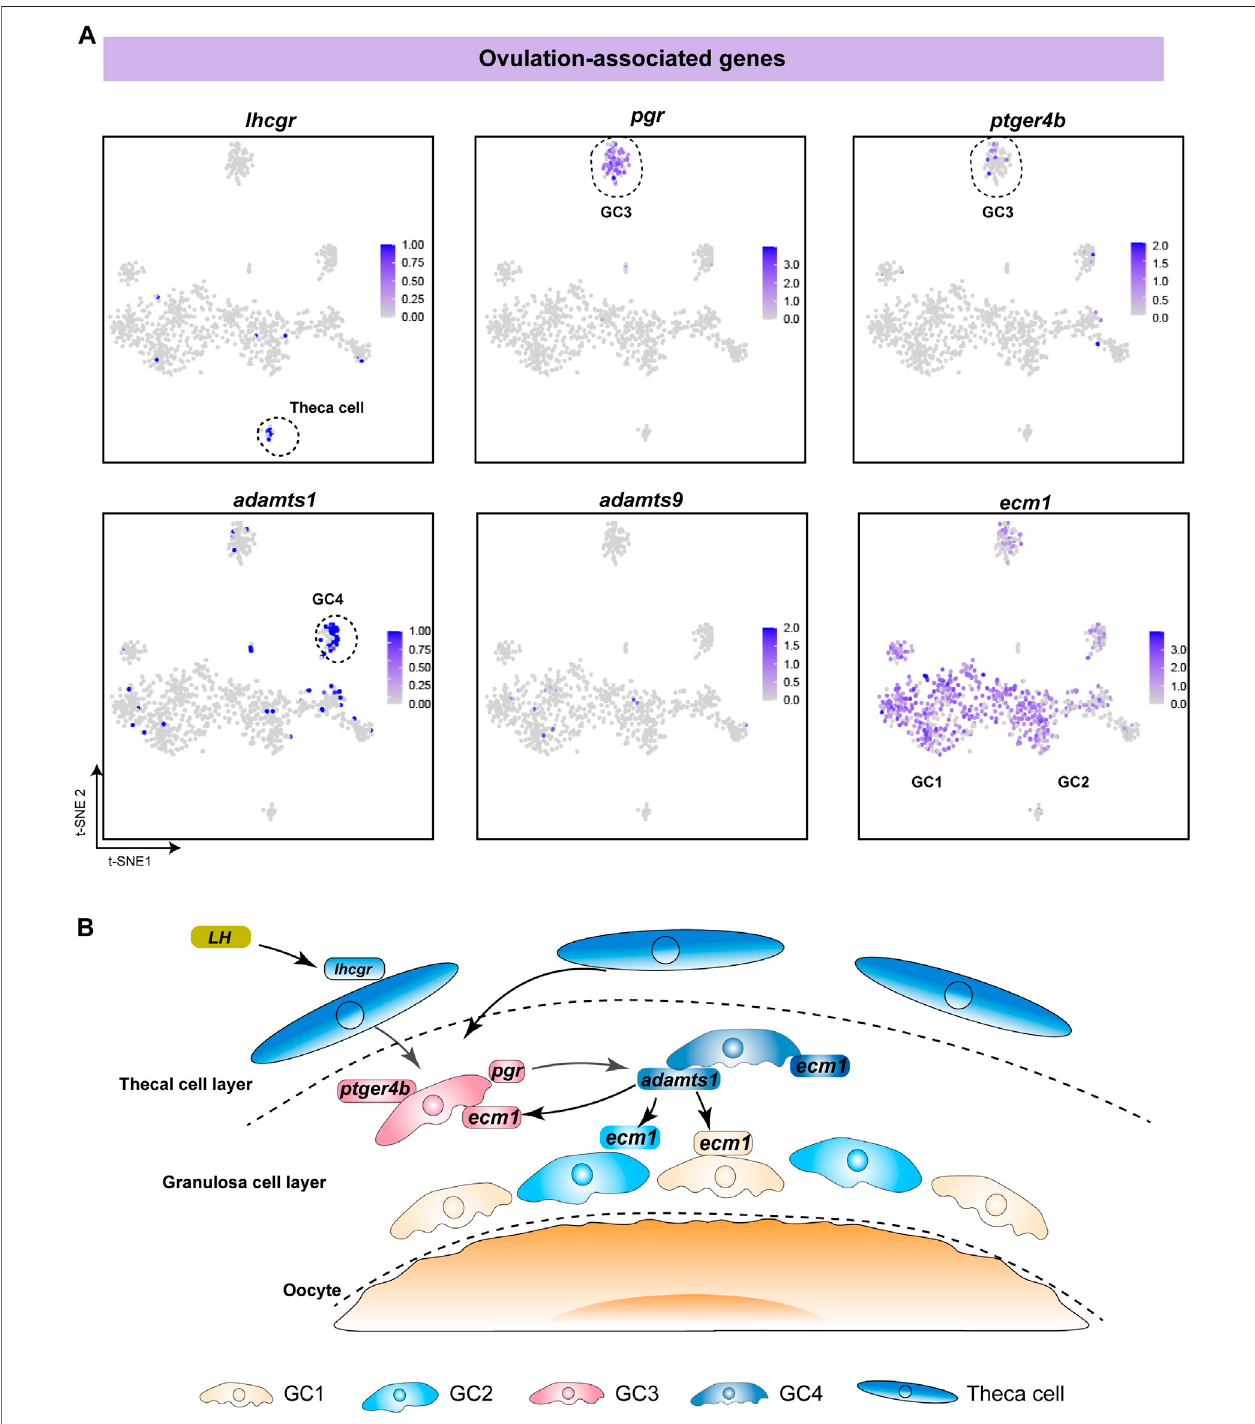
FIGURE 5 | Analysis of speci fi c expression patterns of ovulation-associated genes. (A) Feature plot of ovulation-associated genes in different follicle cells. The darker the colour, the higher the expression. Black dashed lines indicate the boundaries of the main clusters of interest. (B) Schematic diagram showing the regulatory mechanism of ovulation, involving the synergistic action of different follicle cells in fi sh.